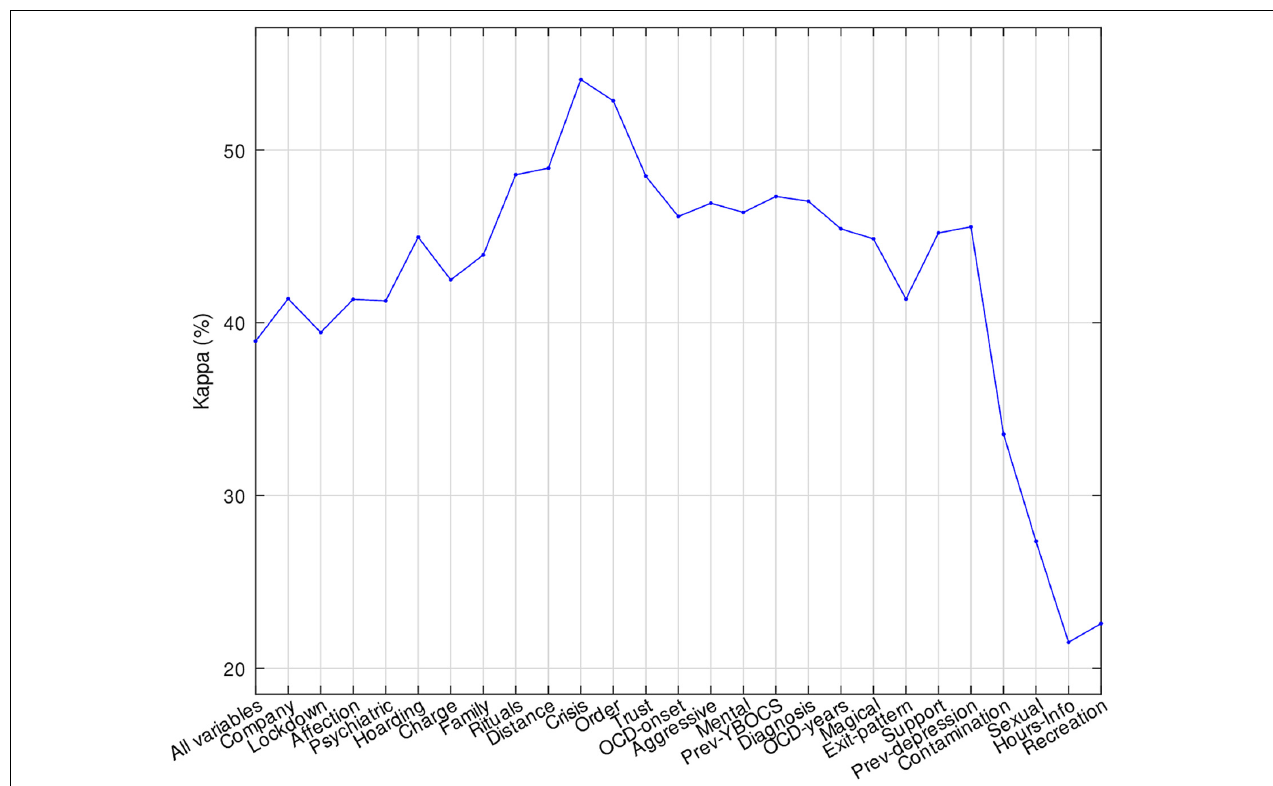
FIGURE 3 | Performance of LDA to predict Suicidal thoughts reducing the set of variables by increasing